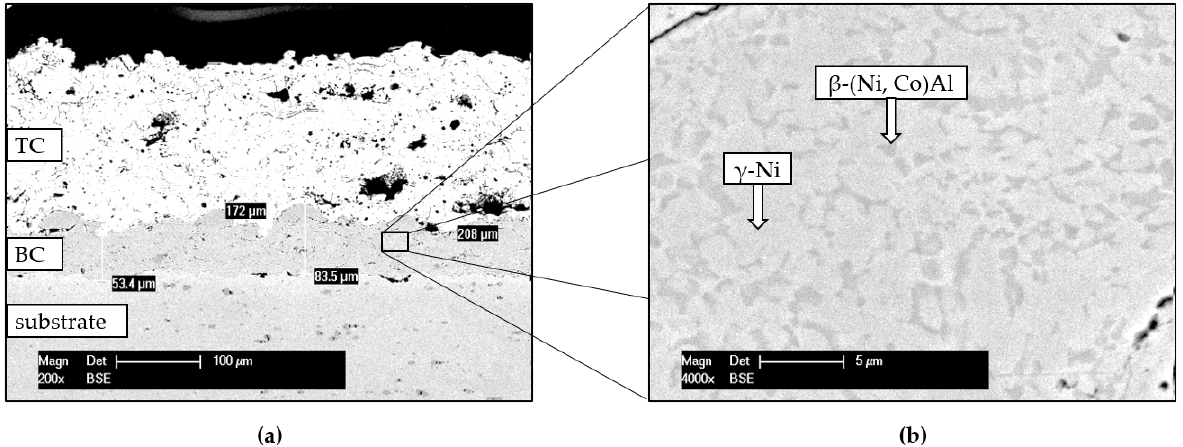
Figure 7. SEM/ cross-section micrographs of the as-sprayed TBC system ( a ) overview, ( b ) higher magnification of BC.